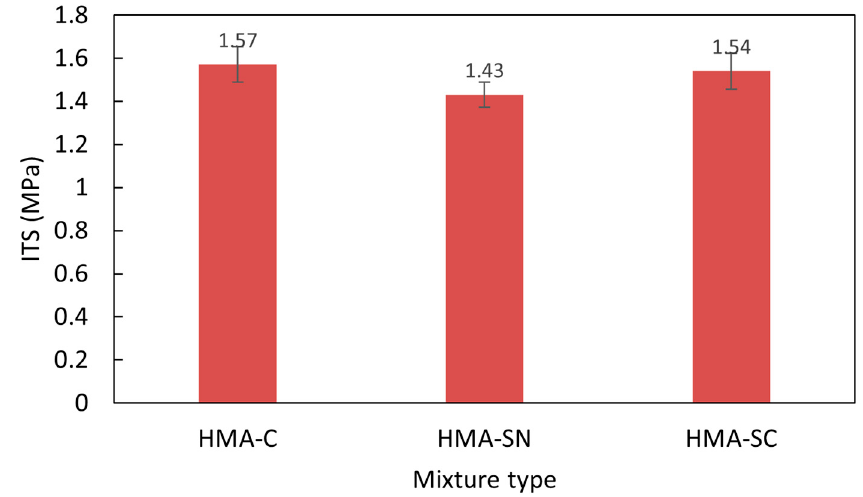
Figure 5. Average indirect tensile strength of the HMA mixtures at 25